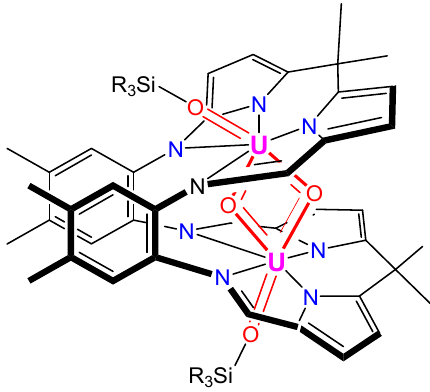
Figure 18. Structure of the butter fl y-shaped diuranium(V) [UO 2 {N(SiR 3 ) 2 } 2 (py) 2 ] complex [49].